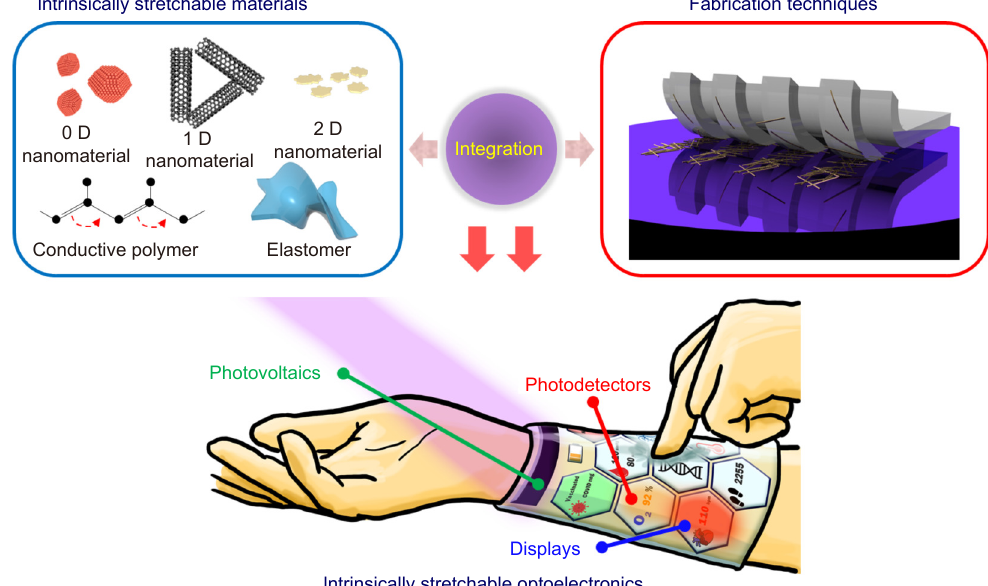
Fig. 1 | Strategy for the development of intrinsically stretchable optoelectronics, based on intrinsically stretchable materials and novel fabrication